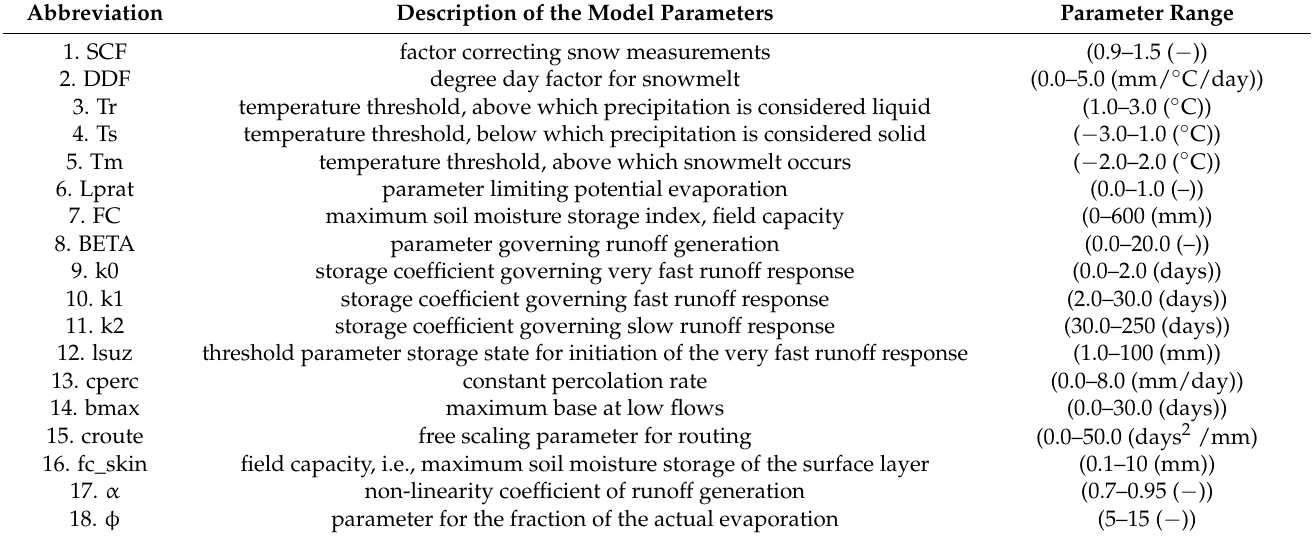
Table 2. TUW_dual model parameters with their ranges for 209 Austrian catchments [25]. Reproduced with permission from [Juraj Parajka], [Matching ERS scatterometer based soil moisture patterns with simulations of a conceptual dual layer hydrologic model over Austria, Hydrol. Earth Syst. Sci., 13, 259–271, 2009]; published by [www.hydrol-earth-syst-sci.net/ 13/259/2009/, accessed on 24 November